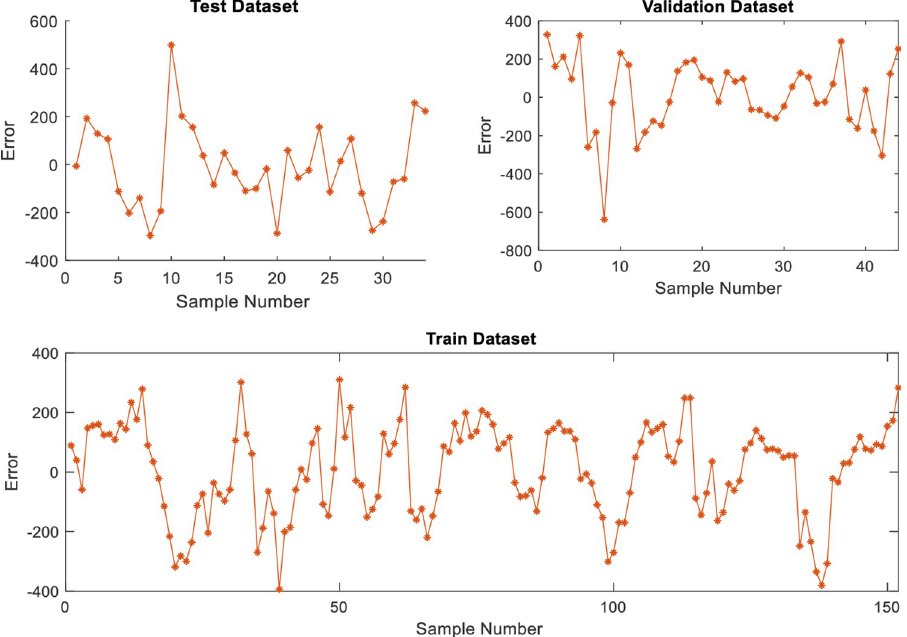
Fig 5. Error analysis of neural network based on the validation